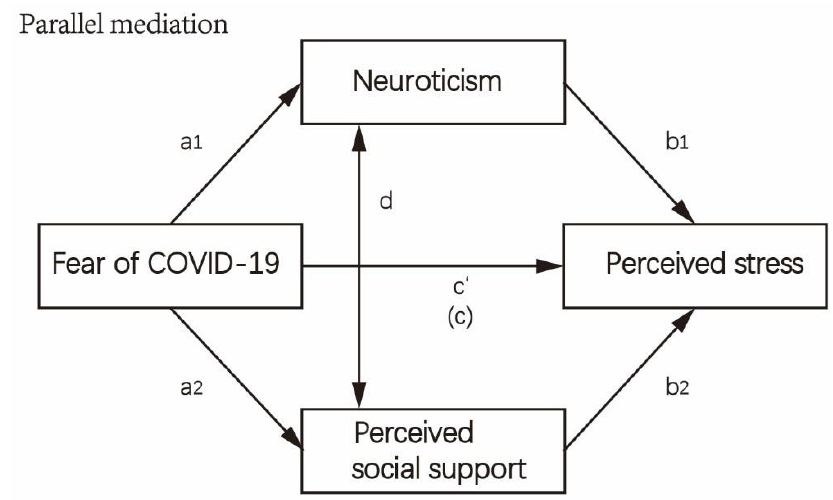
Figure 1. Hypothetical parallel mediation model description. The coefficient “a1” symbolizes the regression coefficient between fear of COVID-19 and neuroticism; the coefficient “b1”, between neuroticism and perceived stress. The coefficient “a2” refers to the sectional regression coefficient between fear of COVID-19 and perceived social support; the coefficient “b2”, between perceived social support and perceived stress; and the correlation “d”, between neuroticism and perceived social support. The coefficient “c’” represents the relationship between fear of COVID-19 and perceived stress when the mediators are added. The coefficient “c” stands for the coefficient in the regression model without the mediators.